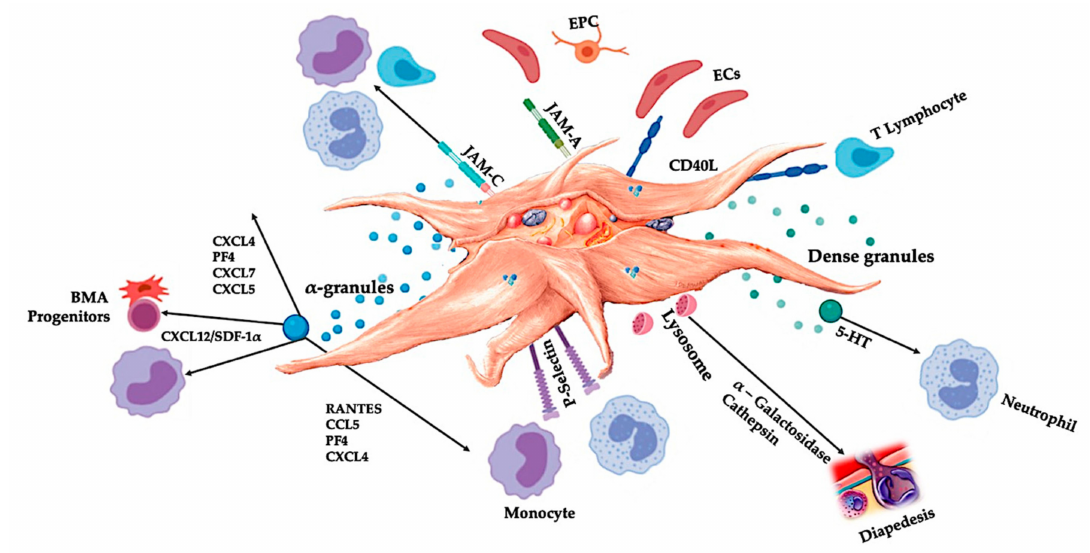
Figure 3. Activated platelets, releasing PGF, and adhesion molecules mediate a variety of cellular interactions: chemotaxis, cell adhesion, migration, cell di ff erentiation, and stipulate to immunomodulatory activities [67,68]. These platelet cell-cell interactions contribute to angiogenesis [46, 69,70] and inflammatory [71,72] activities, ultimately to stimulate tissue repair processes. Abbreviations: BMA: bone marrow aspirate, EPC: endothelial progenitor cell, EC: endothelial cells, 5-HT: serotonin, RANTES: Regulated upon Activation Normal T Cell Expressed and Presumably Secreted, JAM: junctional adhesion molecules type, CD40L: cluster of di ff erentiation 40 ligand, SDF-1 α : stromal cell-derived factor 1 alpha, CXCL: chemokine (C-X-C motif) ligand, PF4: platelet factor 4. Adapted and modified from Everts et al.